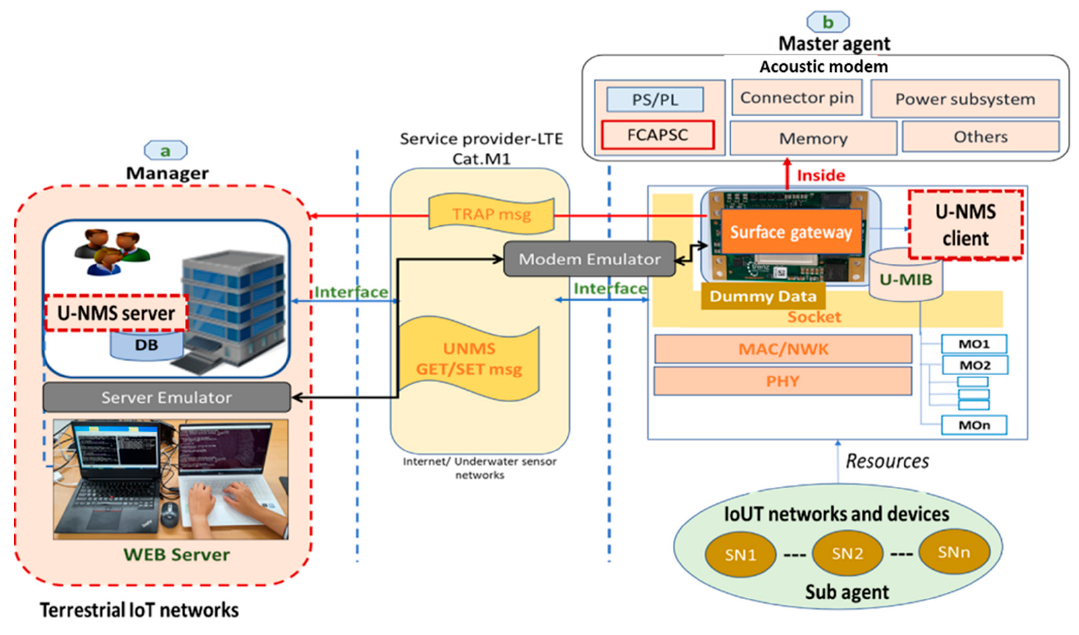
Figure 14. Fundamental prototype design for U-NMS.